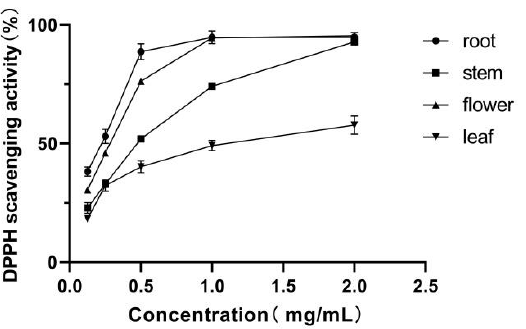
Figure 3. DPPH radical scavenging activities of IEs. Each value is expressed as means ± S.E.M. ( n =